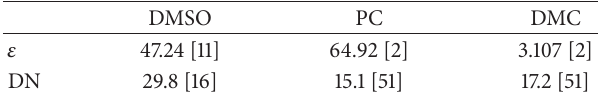
Table 3: Dielectric permittivity 𝜀 and donor numbers DN for DMSO, PC, and